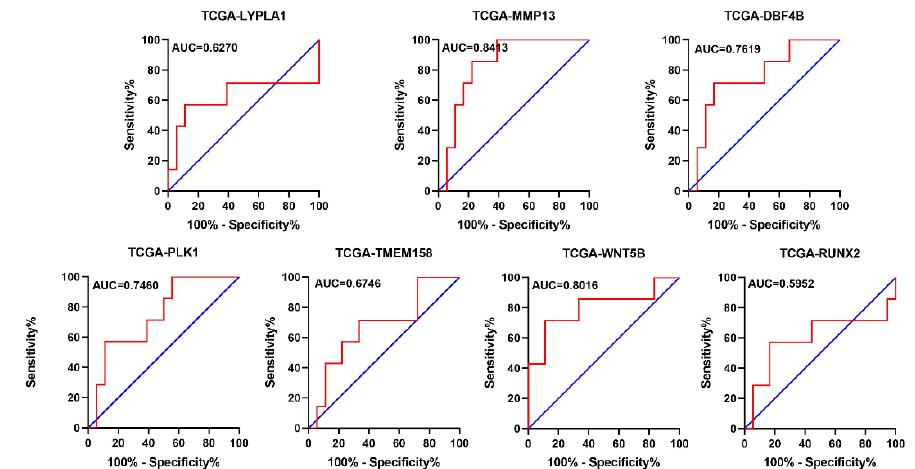
Figure 5. The ROC analyses of overall survival for LYPLA1, MMP13, DBF4B , PLK1, TMEM158, WNT5B, RUNX2 according to transcription data in TCGA. ROC: receiver operator characteristic, AUC: area under the curve.